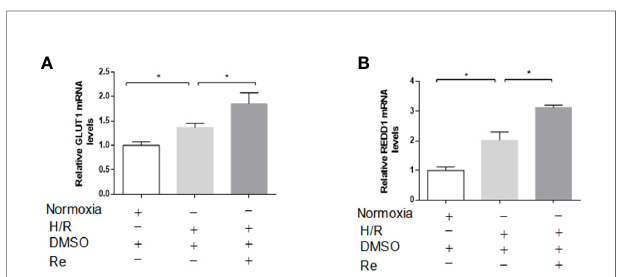
FIGURE 5 | Effects of ginsenoside Re on gene targets of HIF-1 a . (A, B) mRNA levels of GLUT and REDD1 were measured by qPCR (n=5). All data are shown as mean ± SEM, * P < 0.05. H/R, hypoxia reoxygenation; RE, ginsenoside Re; DMSO, Dimethyl